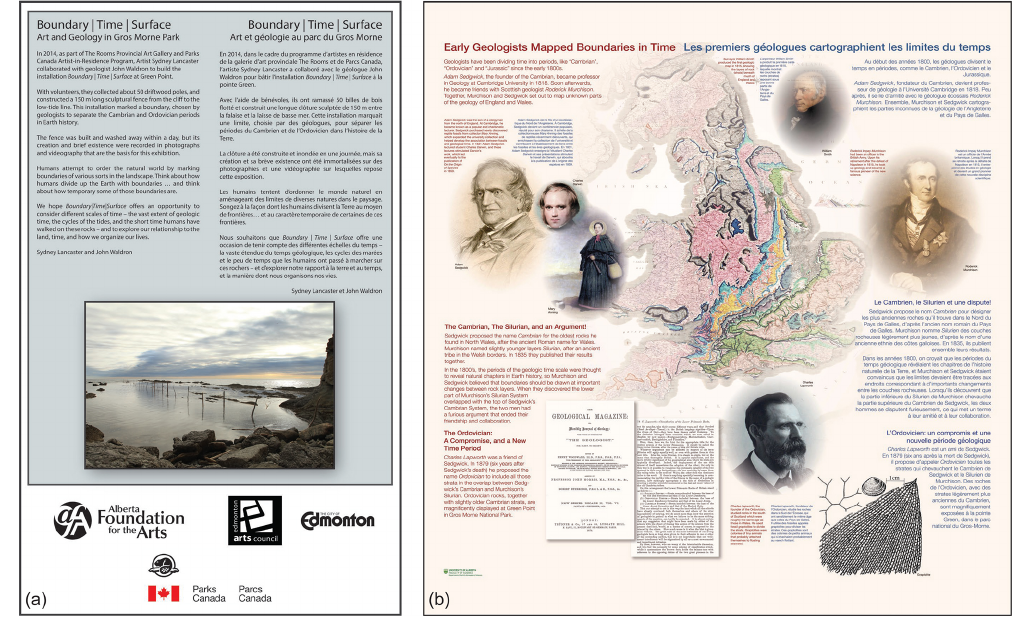
Figure 8. (a) Introductory panel for exhibitions. (b) One of two didactic panels created by the authors, using their own work and images in the public domain, for use in Discovery Centre exhibition. Larger versions and sources are provided in the Supplement. Additional imagery and French translation were provided by Parks